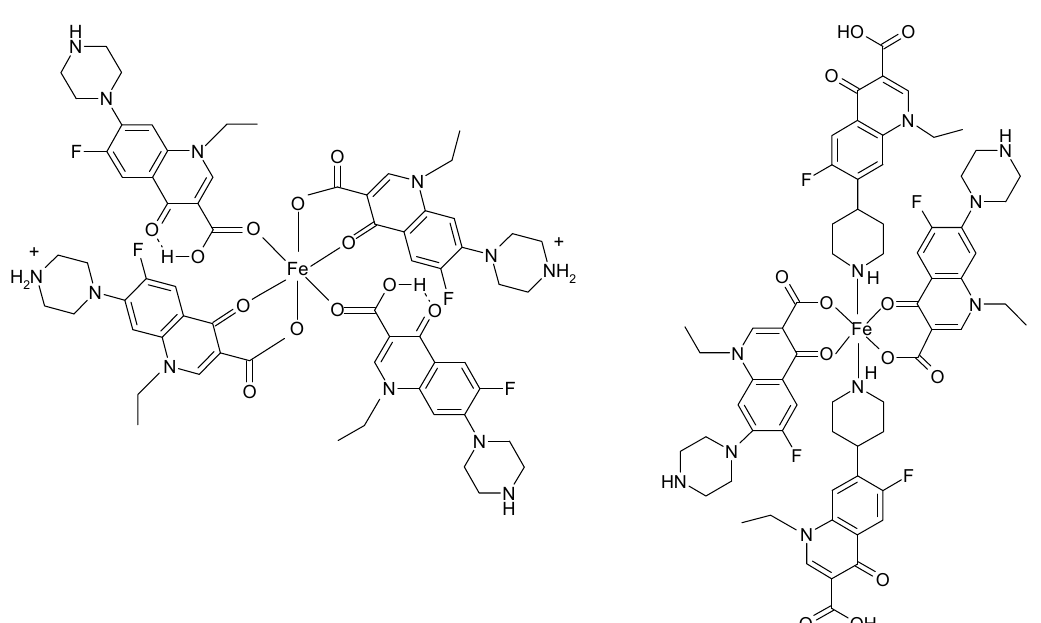
Figure 14. Coordination modes of norfloxacin in ( a ) Fe(H-Nf) ⋅ 4H O (adapted from [122]). ( b ) Fe(Nf) 2 2